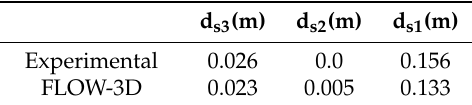
Figure 6. Scour beneath ( A ) first, ( B ) second, and ( C ) third groynes. Table 4. Maximum scour comparison beneath the three groynes between FLOW-3D and experimental results [14].